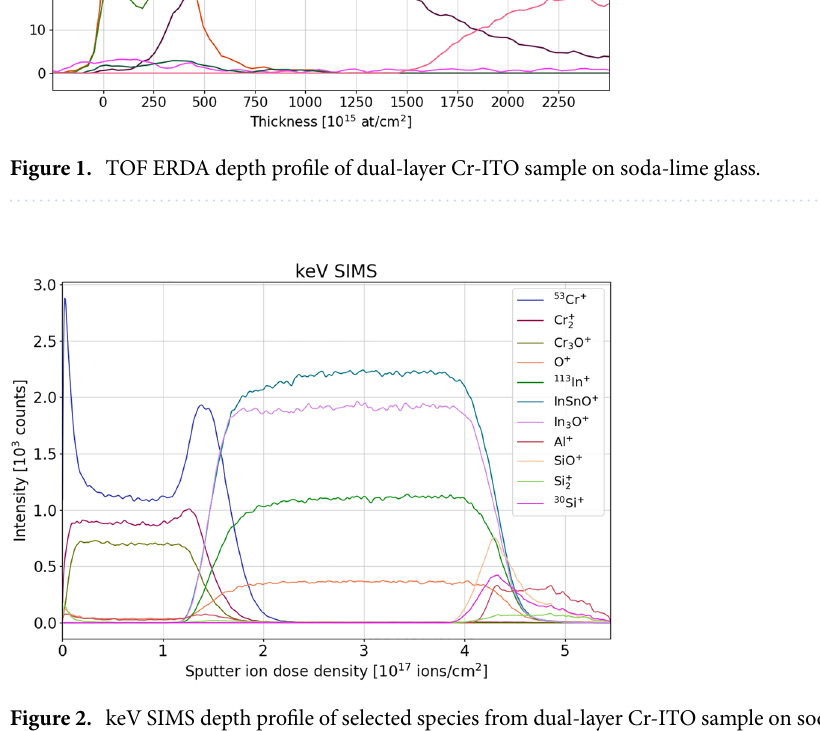
Figure 2. keV SIMS depth profile of selected species from dual-layer Cr-ITO sample on soda-lime